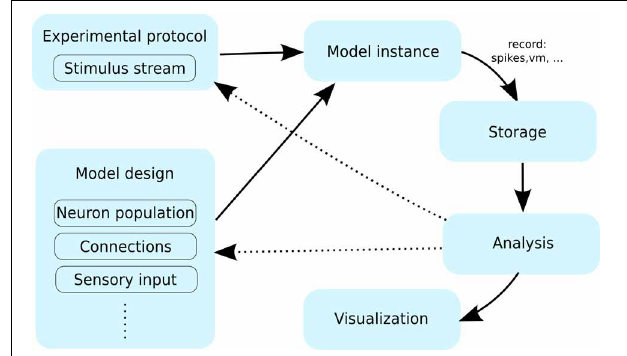
FIGURE 1 | The typical workflow of a neuronal simulation modeling project. A user specifies the model using certain primitives such as neurons, the connections between them and the stimulation protocol. An instance of such a model is then simulated for a period of time, while being presented with stimuli specified by the experimental protocol. During the simulation a range of variables are recorded (e.g., spikes, membrane potential etc.); and typically stored for future processing. After the simulation is finished the data is; this data is then passed through the analysis and visualization protocols. At this point the user can inspect the results, which likely leads to modification of the model or experimental protocol (interrupted arrows), requiring another pass through the workflow